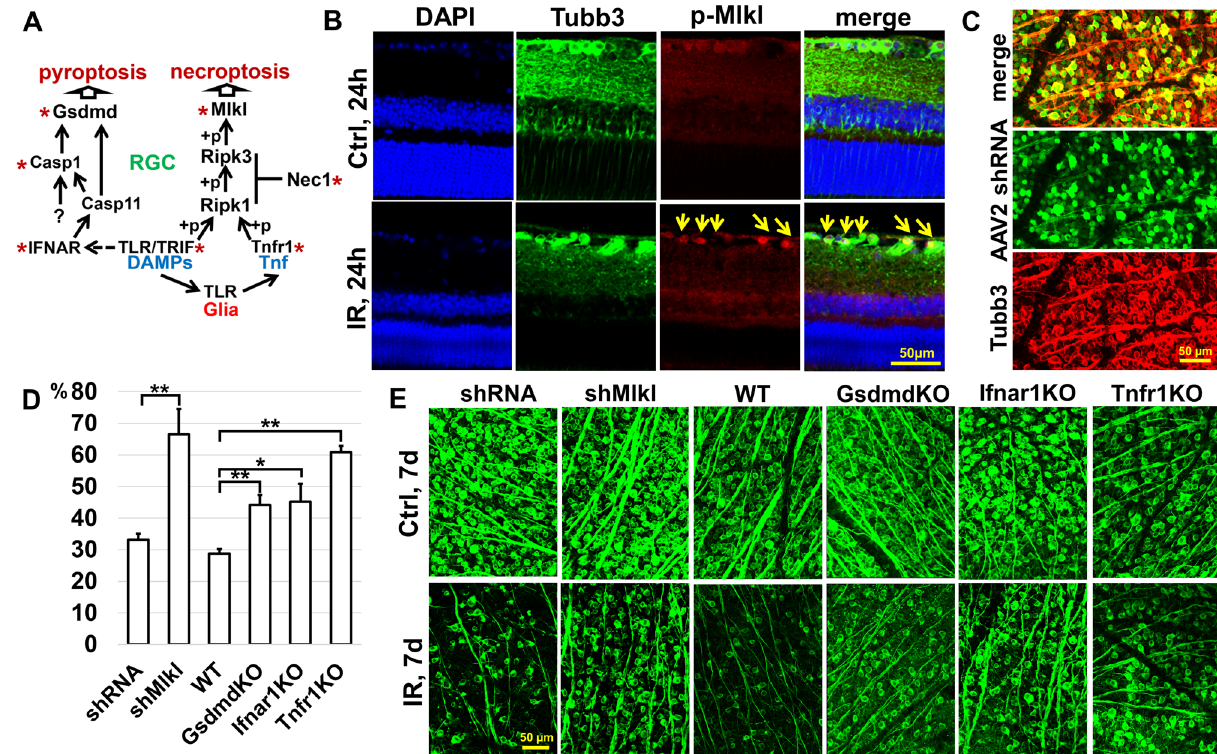
Figure 5. The necroptosis and pyroptosis signaling pathways are active in the IR retina, leading to significant RGC death. ( A ) Inactivation of genes of the necroptosis and pyroptosis signaling pathways significantly reduces retinal damage after IR. The star (*) indicates the genes and inhibitors tested in this and previous studies. ( B ) Immunohistochemistry (IHC) analysis indicates that the Mlkl protein is phosphorylated in RGCs of the IR retina. (p-Mlkl—phosphorylated Mlkl, Tubb3—an RGC marker) ( C ) The representative confocal images show that AAV2 exclusively transduces RGCs in the ganglion cell layer of adult animals with high efficiency. ( D